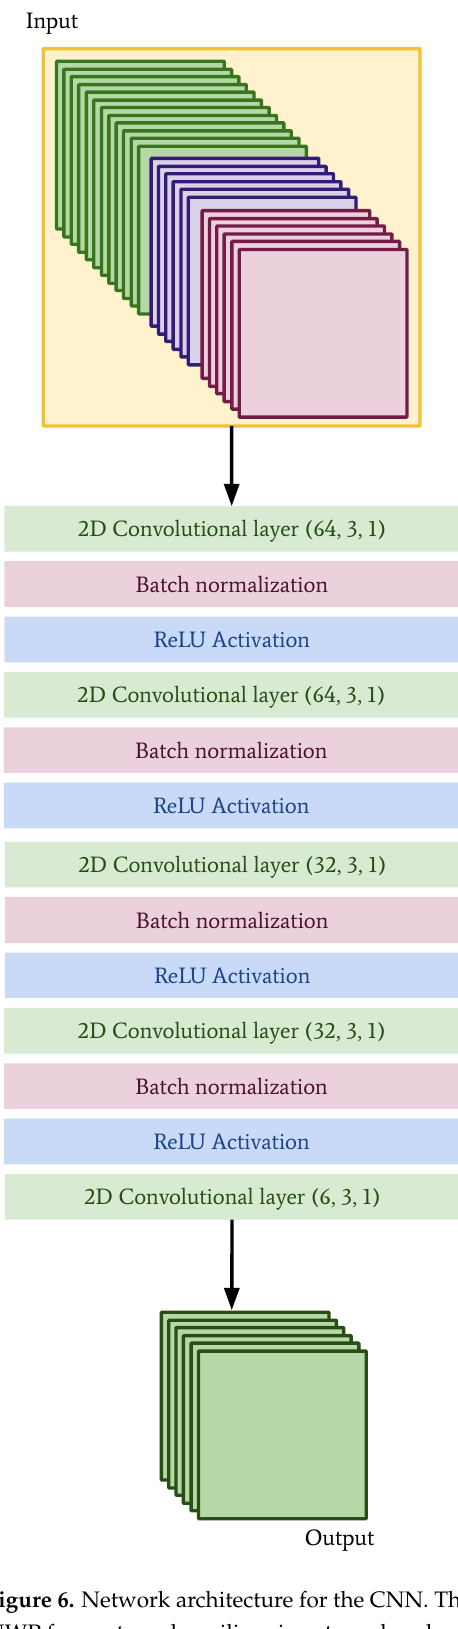
Figure 6. Network architecture for the CNN. The input data are made up of historical observations, NWP forecasts and auxiliary inputs such as land area fraction and altitude. The inputs are stacked, with the resulting dimensions being 40 × 40 ×